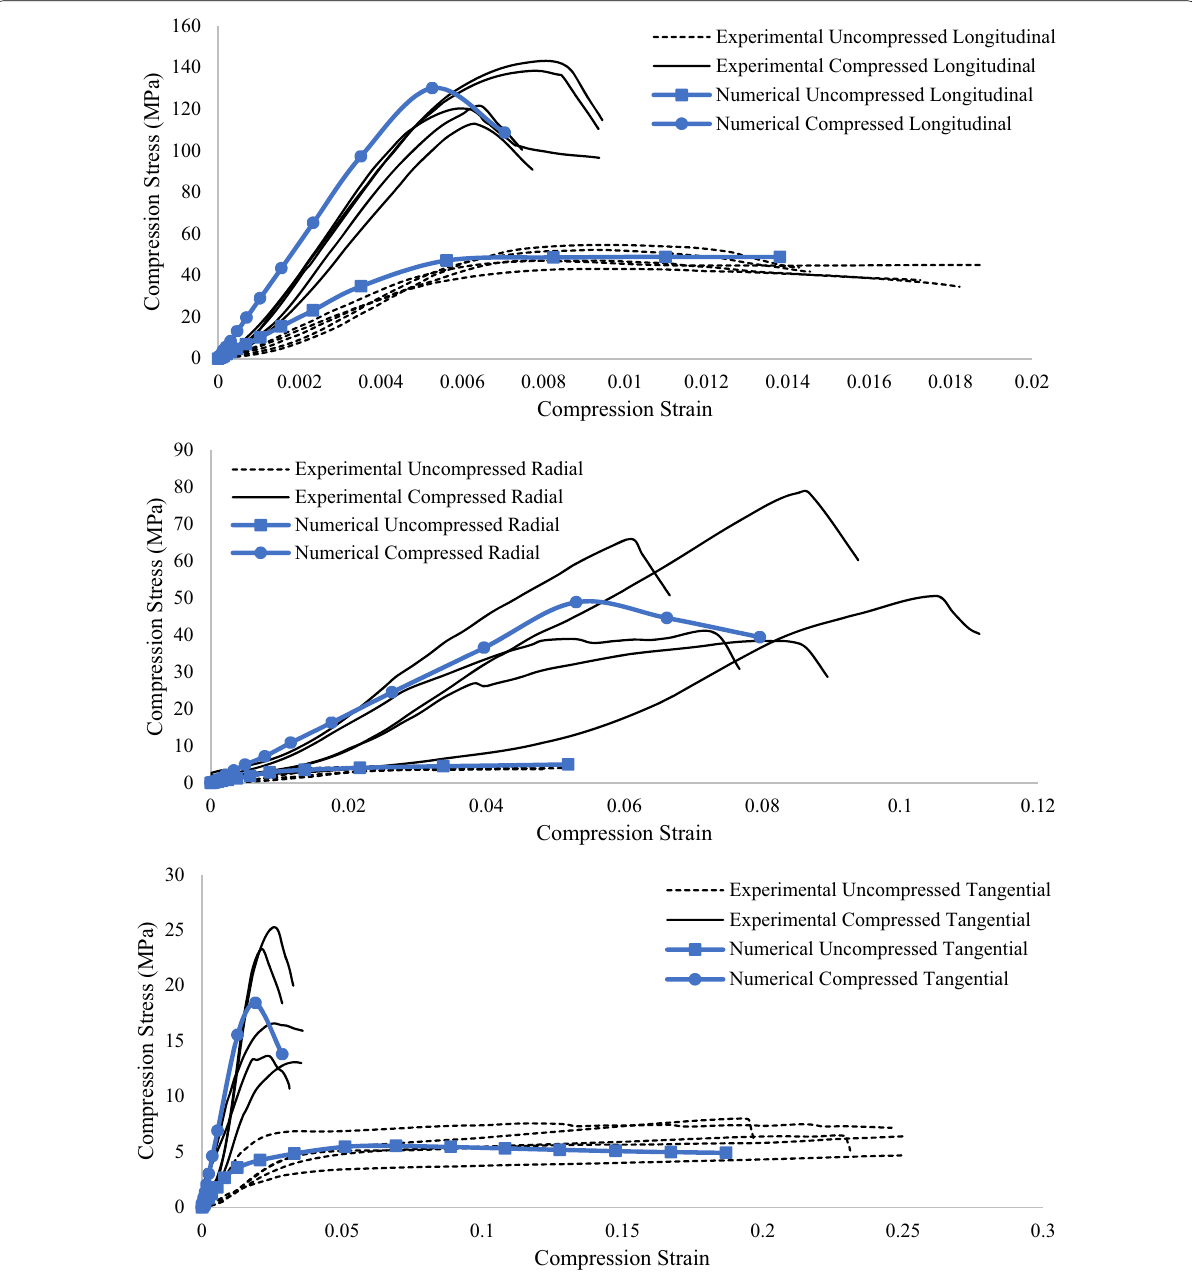
Fig. 9 Compression stress–strain diagrams ( reproduced from Bouhala et al.